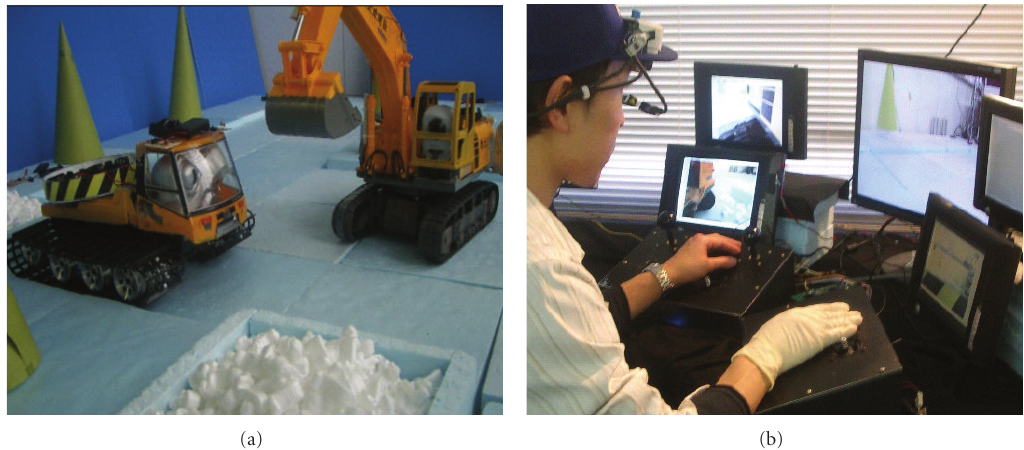
Figure 5: (a) Radio-controlled construction equipment on the work area and (b) the operation console.